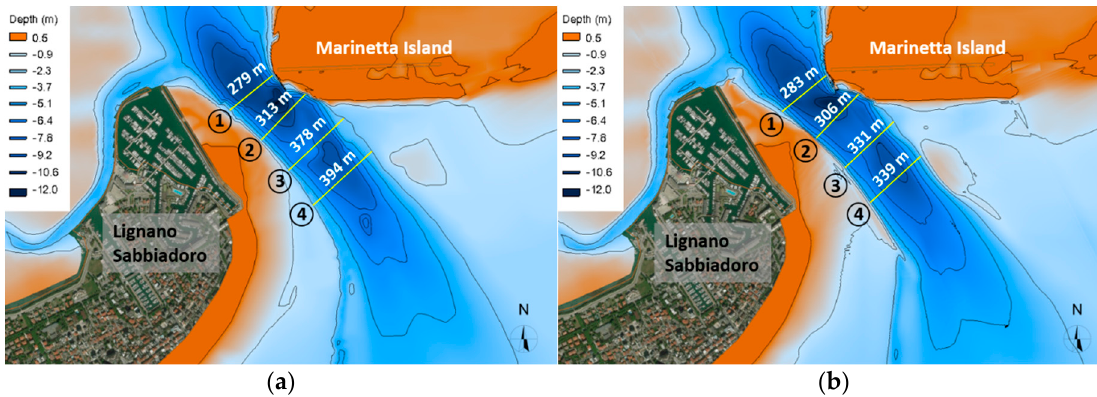
Figure 12. Depth contours resulting ( a ) in the current configuration and ( b ) after the simulation of an average year. The cross width of the tidal inlet, pre- and post-simulation, is indicated along the four sections depicted with the yellow lines and the numbers in the circles.